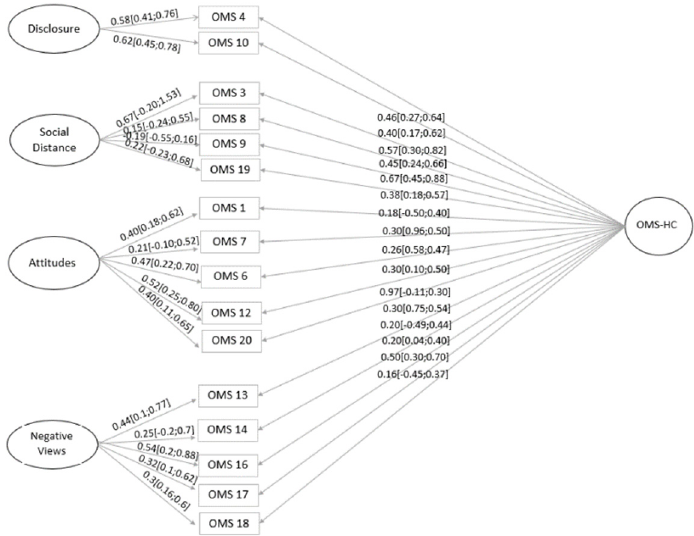
Figure A2. Path diagram for the bifactor model. The general factor “g1” represents the general OMS construct and each of the four specific factors represents one specific subscale. The bifactor allow us to understand to what extent the properties of the latent variables are different from each other and different from the general OMS construct, as for example, if the total sum score with unit weight represents well the OMS construct, and if this specific subscale is unique. Values in the graph are standardized model coefficients (factor loadings). We removed residual variances for clarity.